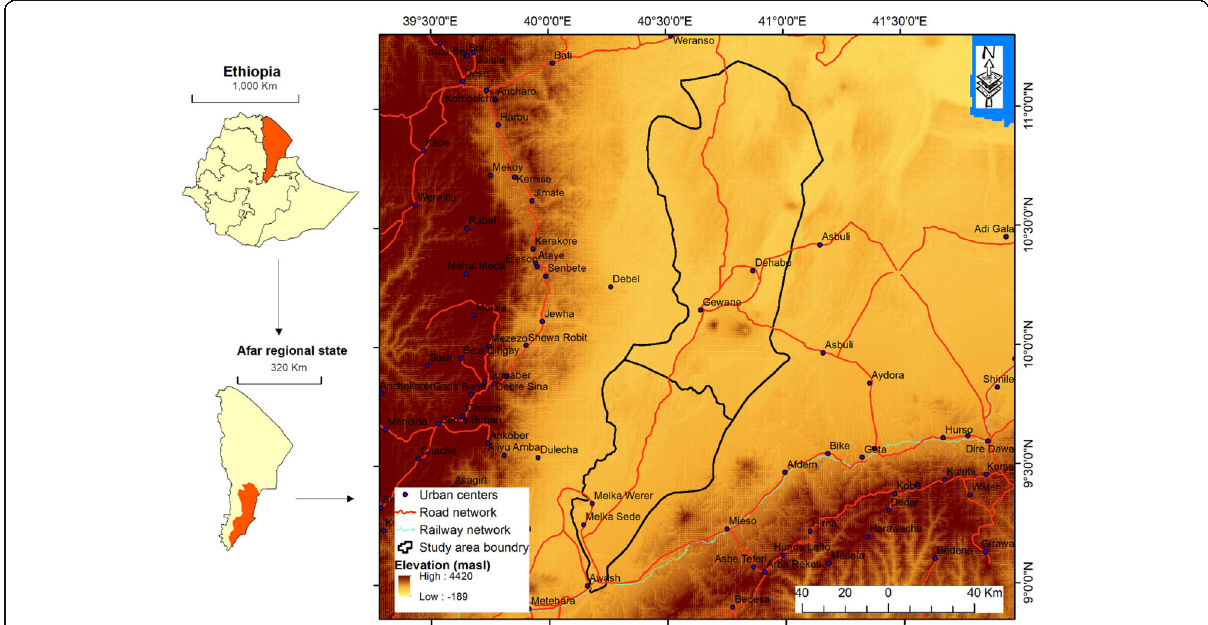
Fig. 1 Map of Amibara and Gewane in Afar, northeast